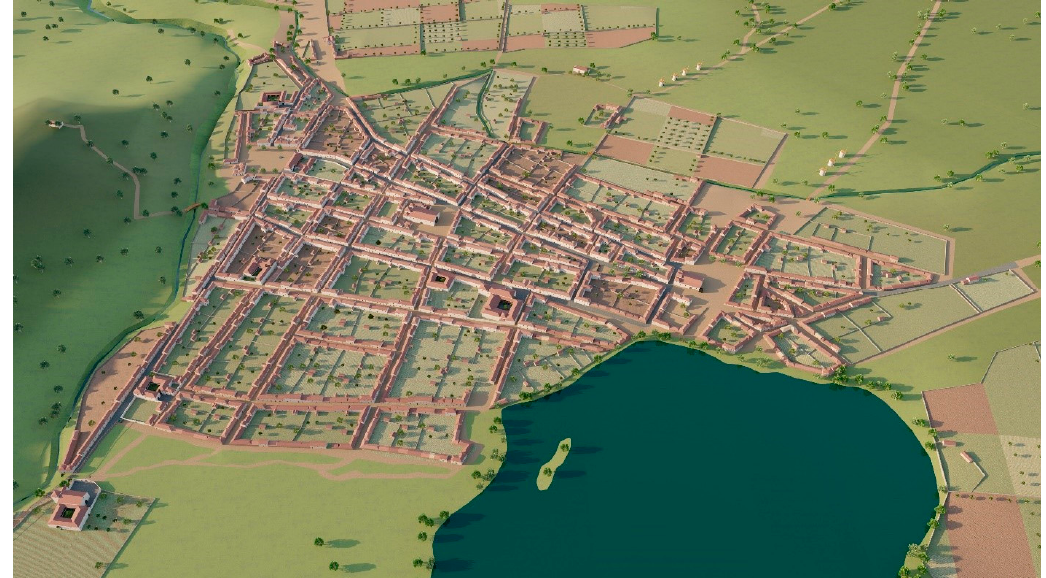
Figure 23. City reconstruction of San Cristóbal de La Laguna in 1588.